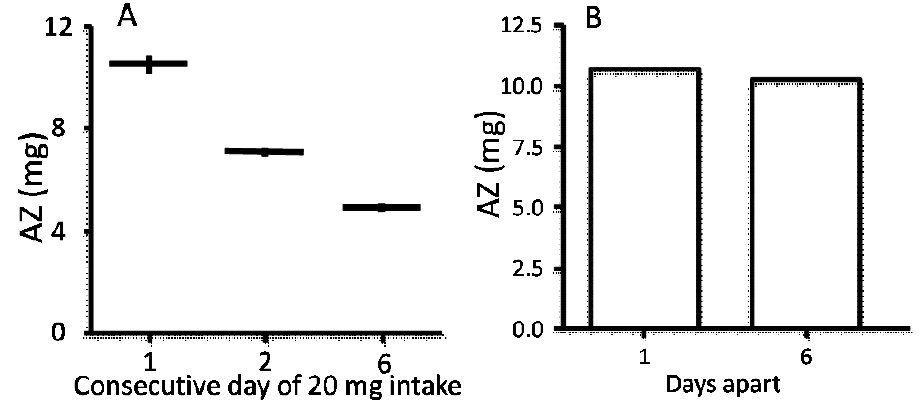
Figure 2. The absorbed zinc (AZ) in adults in the post-absorptive state after ingestion of a 20 mg zinc oral dose (IZ) for 1, 2 and 6 consecutive days ( A ); The AZ in adults in the post-absorptive state after ingestion of a 20 mg zinc oral dose 6 days apart ( B